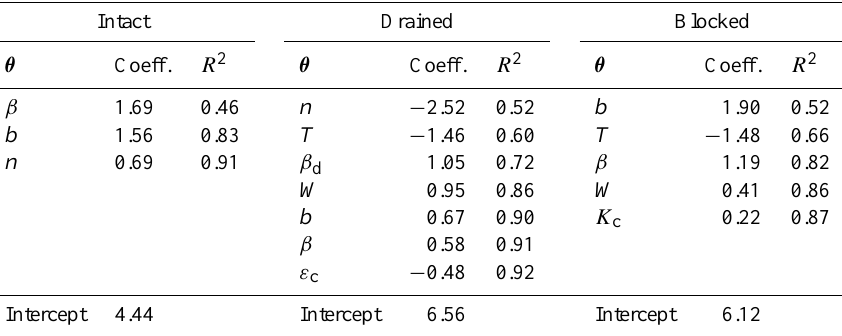
Fig. 3. Difference in peak flows: (a) drained minus intact (positive values indicate increases in peak flows following drainage); (b) drained minus blocked (positive values indicate decreases in peak flows following drain blocking); (c) intact minus blocked (positive values indicate that blocked sites have lower peak flows than intact sites). Light grey areas are the 5-95% range, dark grey areas are the 25-75% range, and the heavy black line is the median difference. Table 3. Regression models for intact, drained and blocked values of q ( r ) . The parameters and their regression coefficients are shown in increasing order of significance. R 2 -values are cumulative, demonstrating the effect of progressive addition of parameters. Intact Drained Blocked θ Coeff. R 2 θ Coeff. R 2 θ Coeff. R 2 β 1.69 0.46 − 2.52 0.69